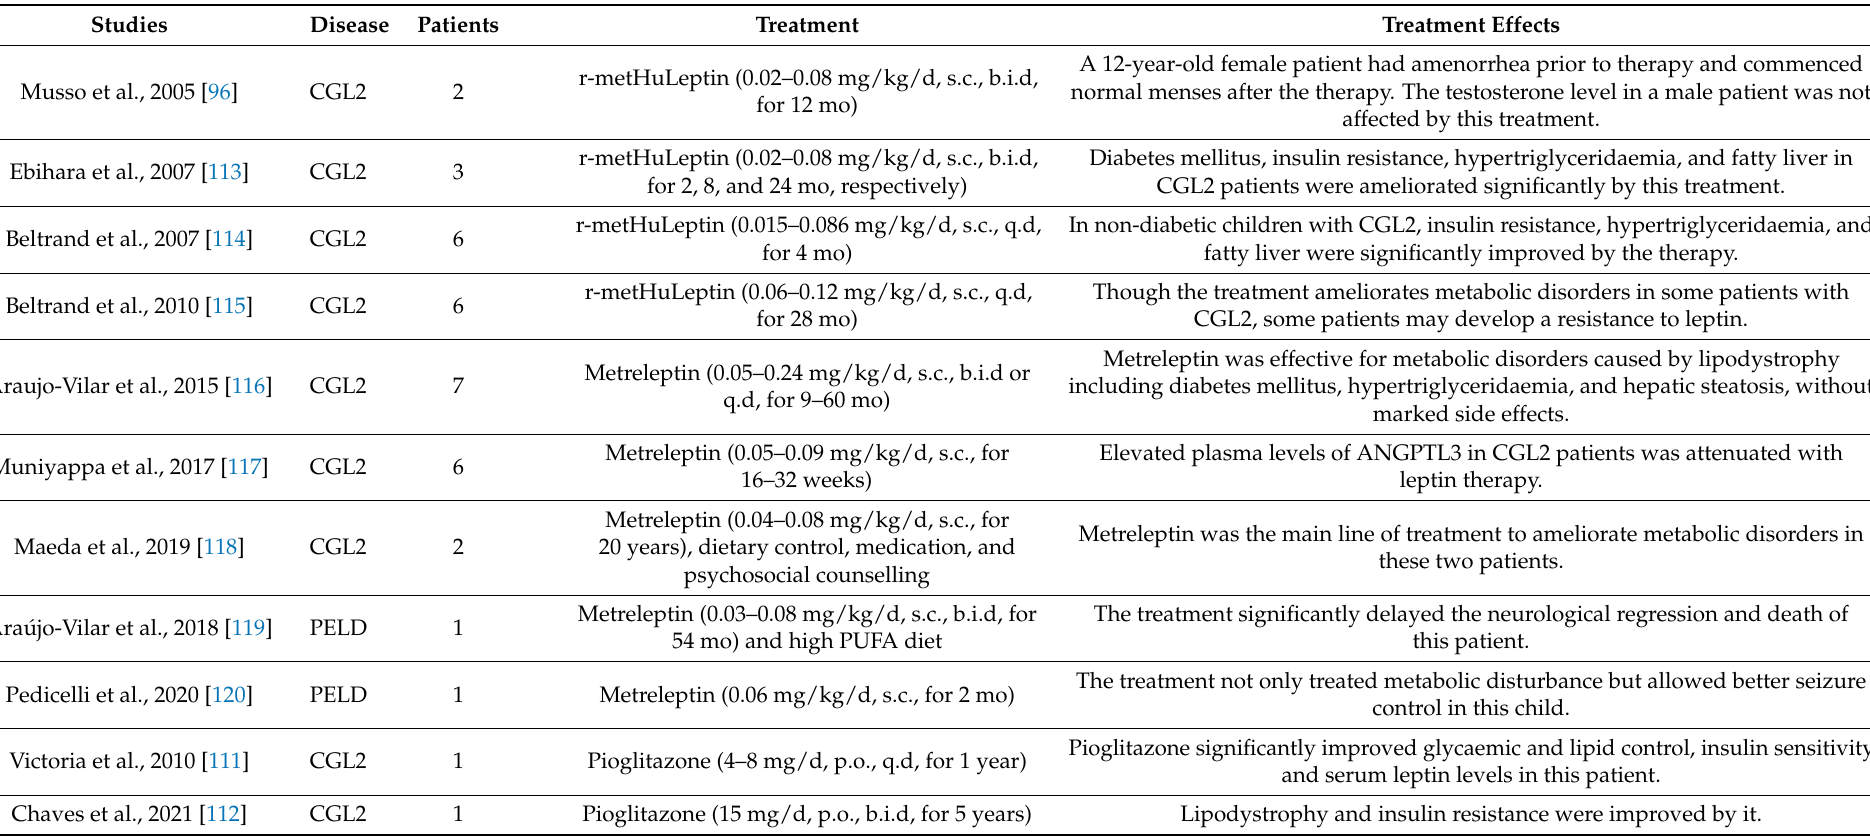
Table 3. Leptin-based treatment and pioglitazone treatment for BSCL2 -mutation-related human